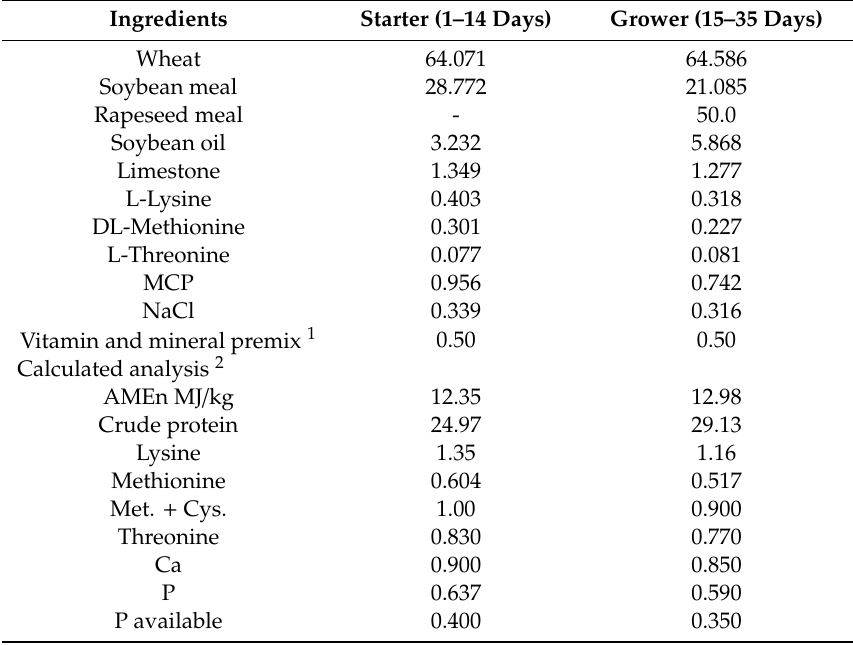
Table 1. Composition of starter and grower diets, g /